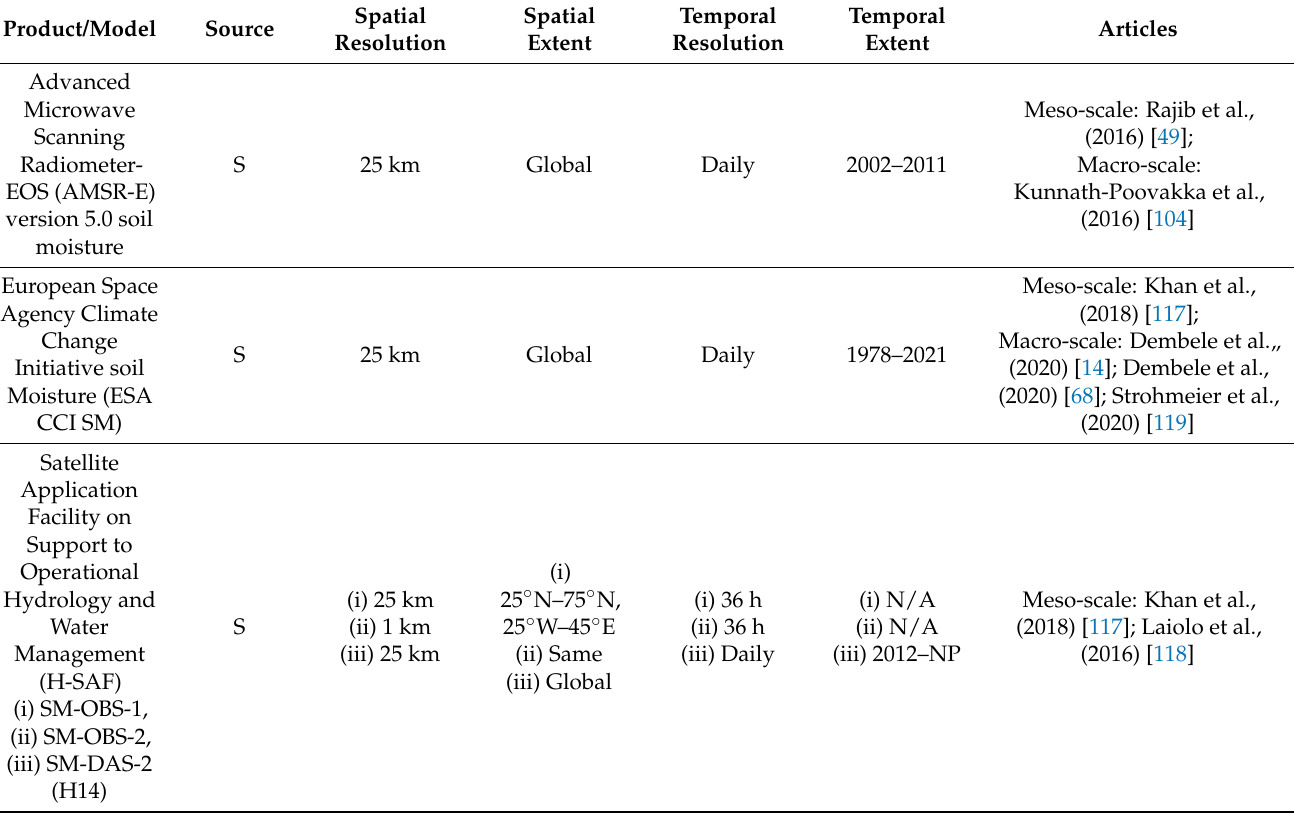
Table A8. Soil moisture products used in reviewed